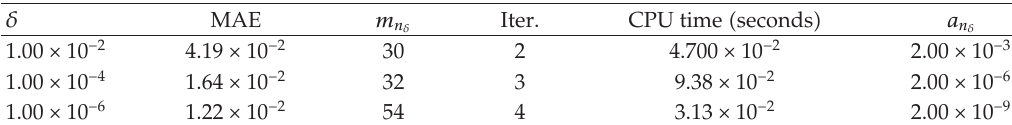
Figure 6: Example 3.6: the stability of the approximate solution. Table 6: Example